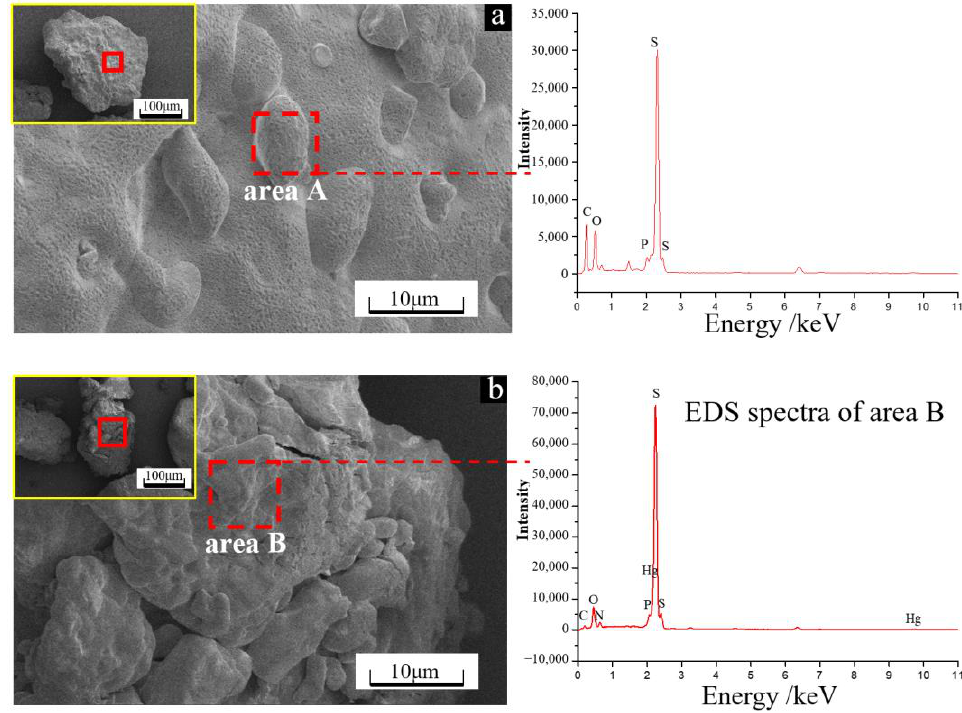
Figure 5. SEM image and EDS spectra of the solid particulate on day 48 for the groups without ( a ) and with ( b ) Hg 2+ .